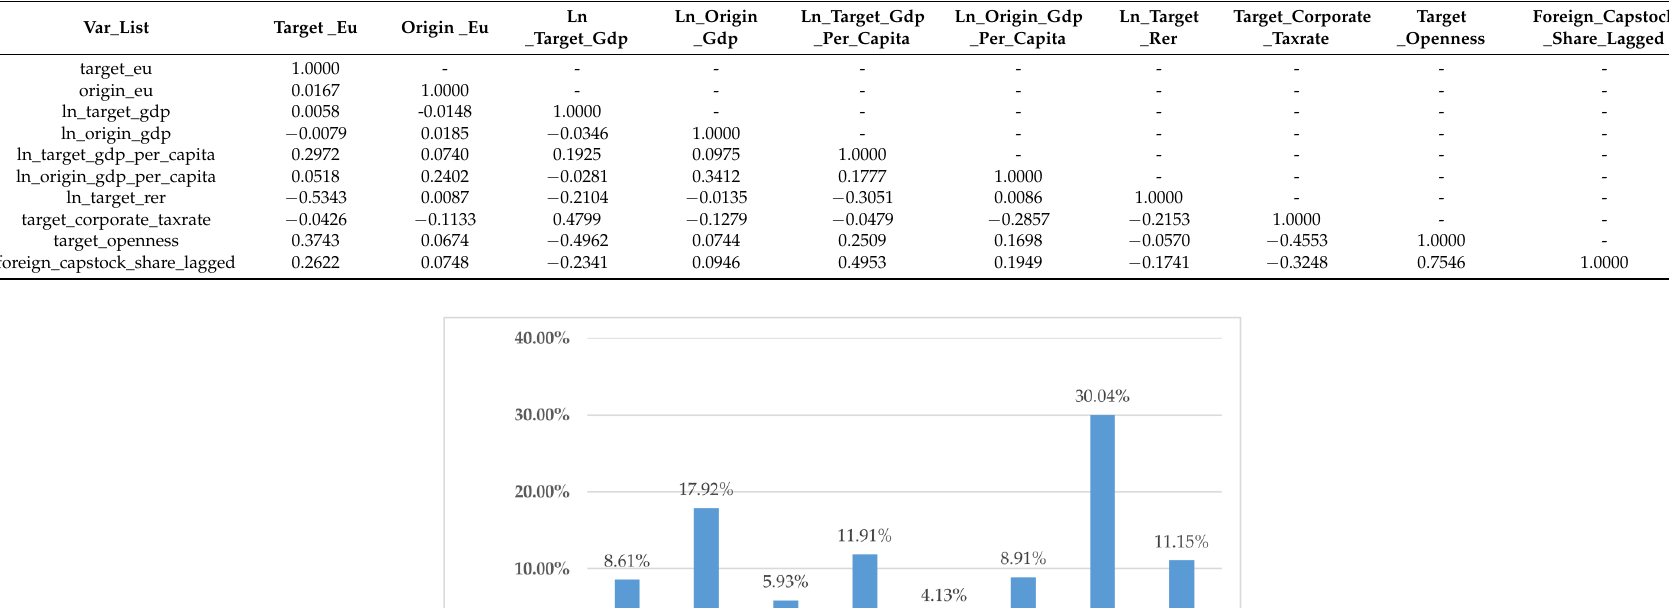
Table A2. Correlation Matrix of all variables (excluded FE and “negative flow”-dummies).